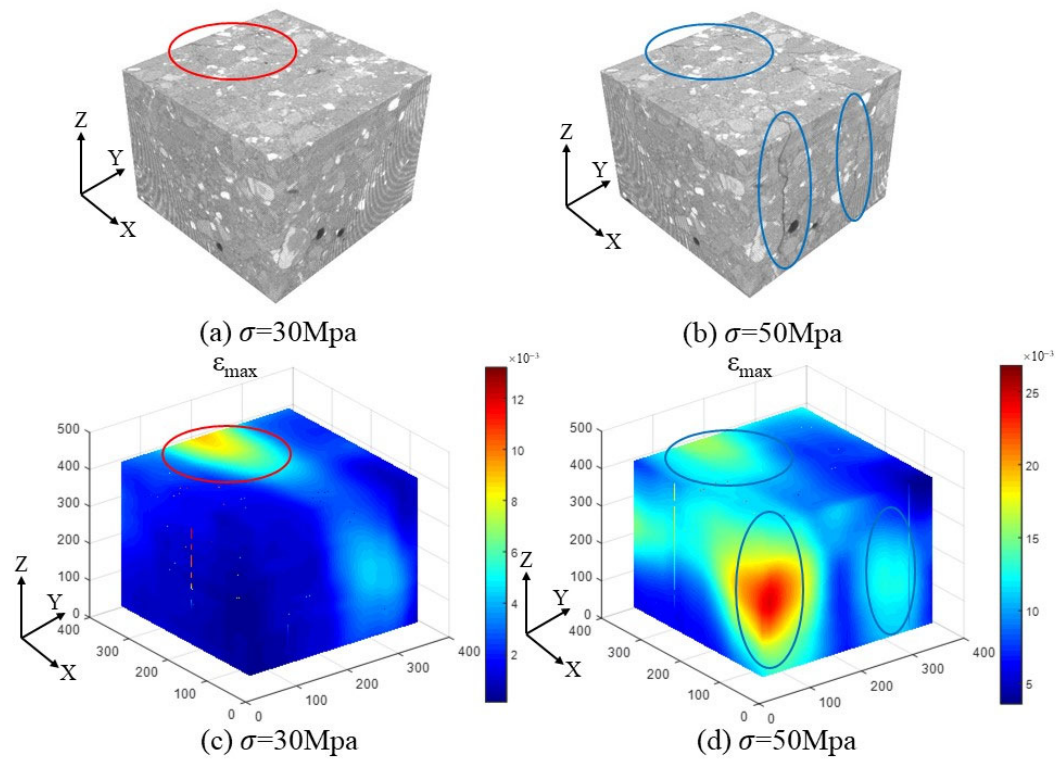
Figure 12. DVC computing 3D image and distribution of principal strain under different stress stages.